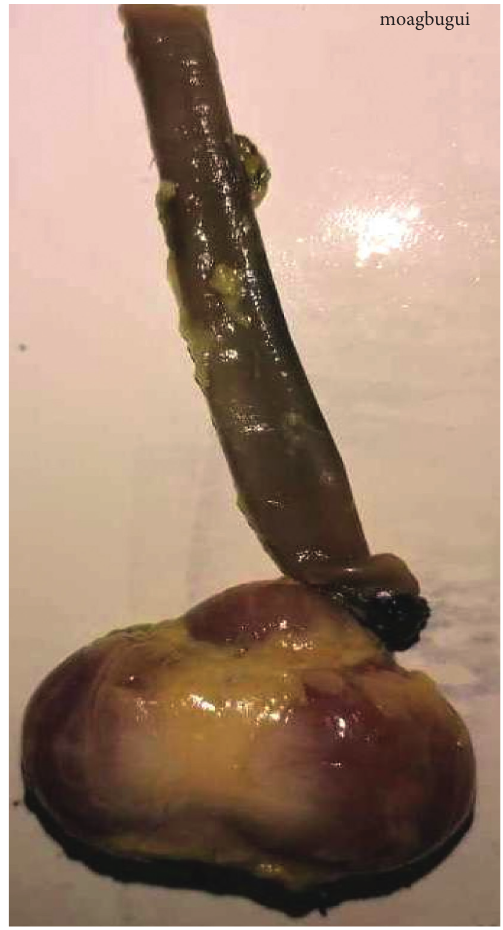
Figure 6: Gizzard-like stomach of H.